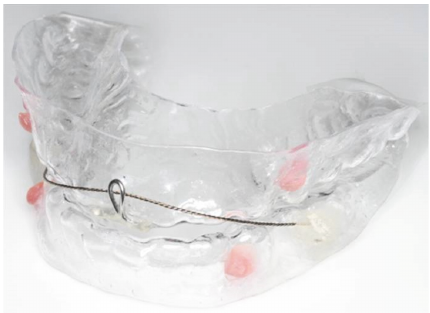
Figure 1: The mandibular advancement appliance.